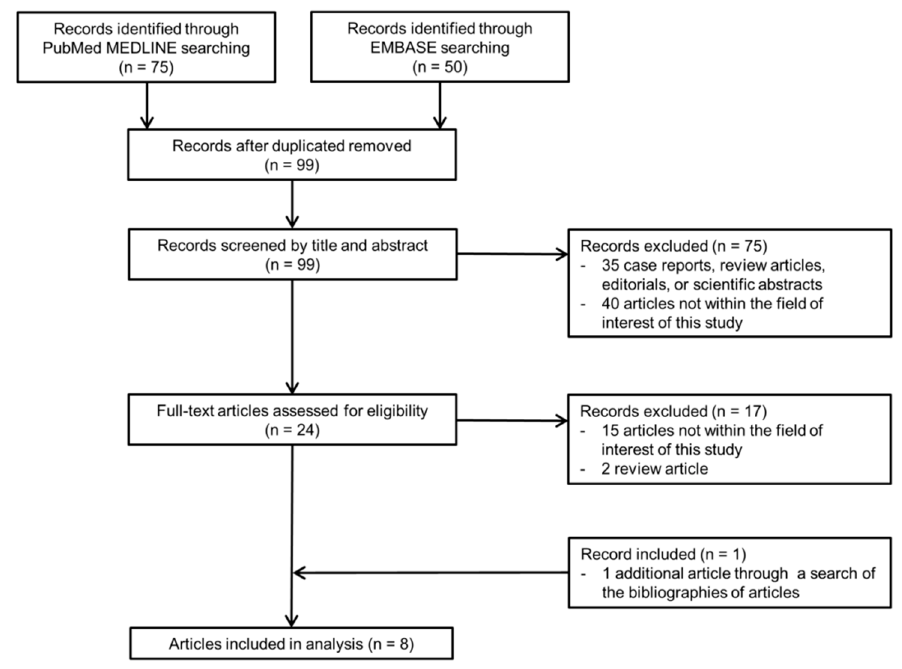
Figure 1. Flow diagram of the article selection process.